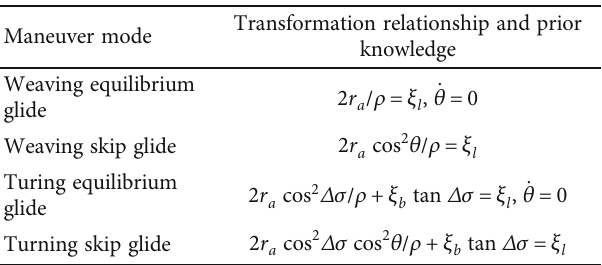
in equilibrium glide. (b) is the variation of r a Table 1: Transformation relationship